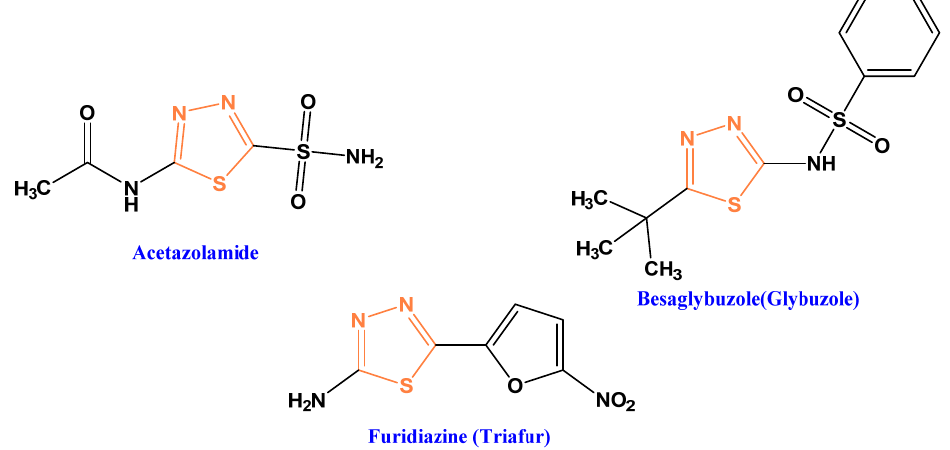
Figure 1. Chemical structures of drugs containing 1,3,4-thiadiazole moiety.